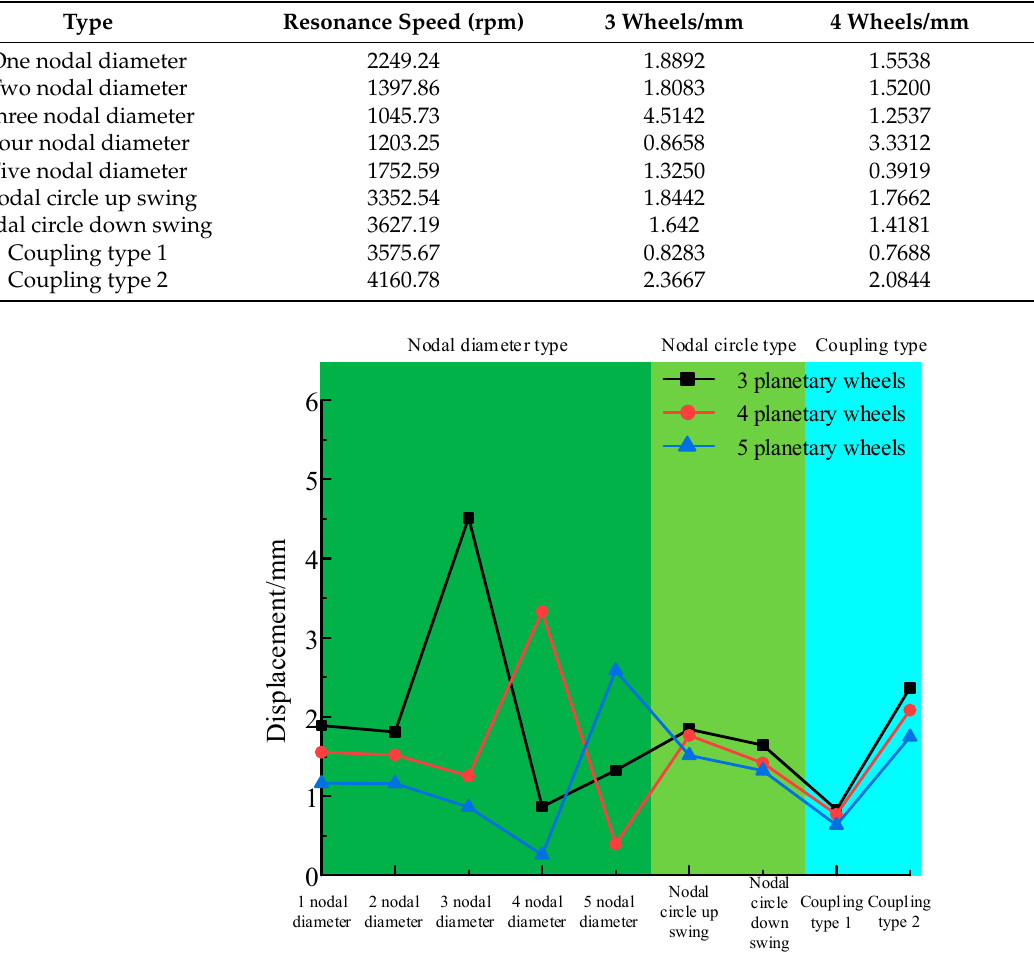
Figure 11. Comparison of maximum amplitude of radial vibration displacement response.